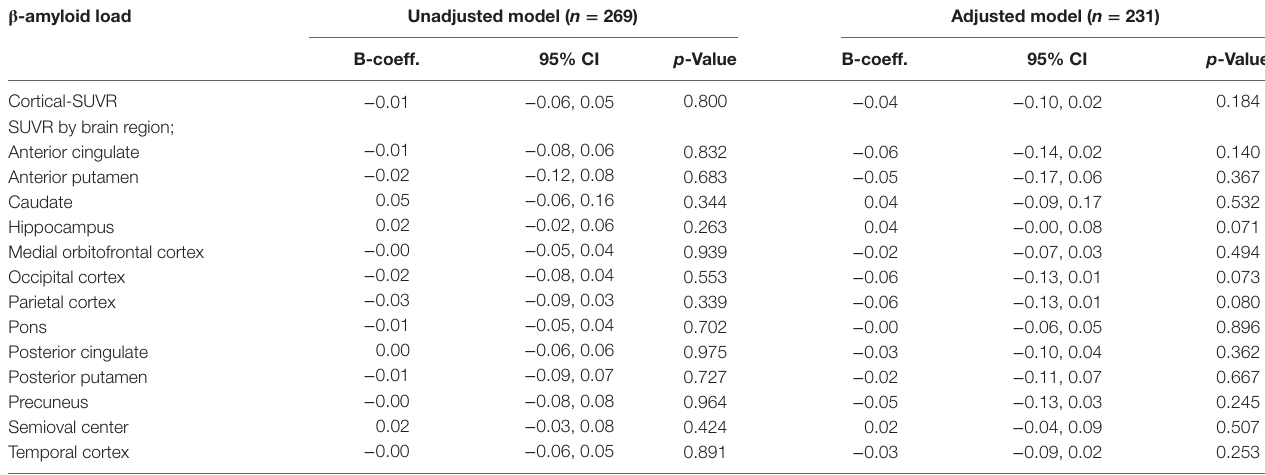
TaBle 2 | Multiple linear regressions examining the cross-sectional associations between fatigue at the clinical exam closest to PET-scan and cerebral β -amyloid